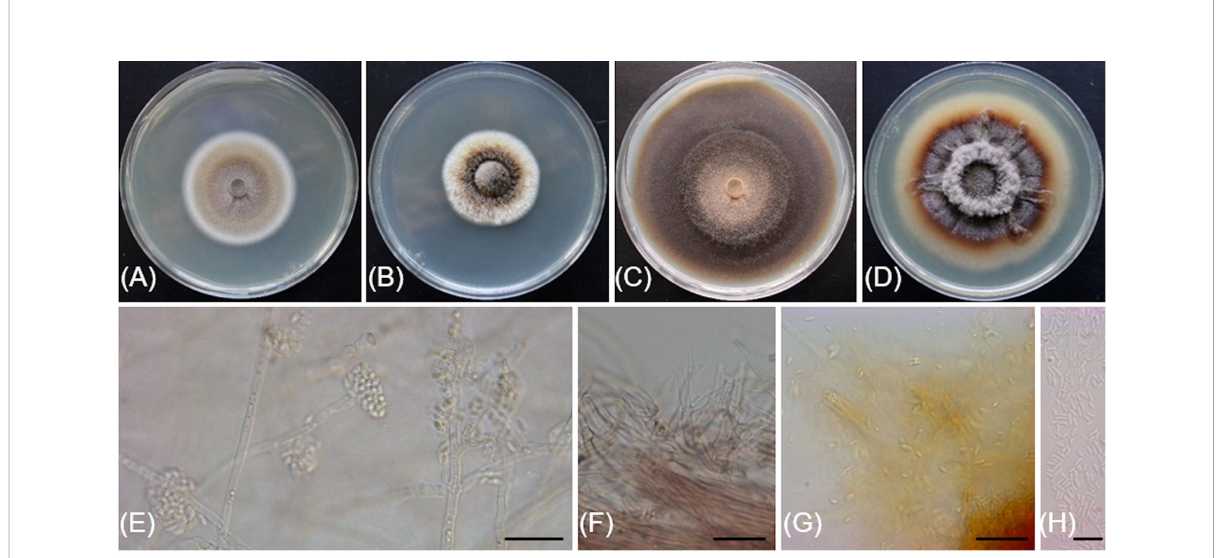
FIGURE 4 Cadophora columbiana (CBS 149299/Bent718). (A, B) 14-day-old colonies on MEA and PDA media, respectively. (C, D). 55-day-old colonies on MEA and PDA media, respectively. (E) . Conidiophores, conidiogenous cells and conidia aggregated in heads. (F) Phialides and colarettes. (G, H). Conidia. Scale bars: 20 µm (E – G) ; 10 µm (H)